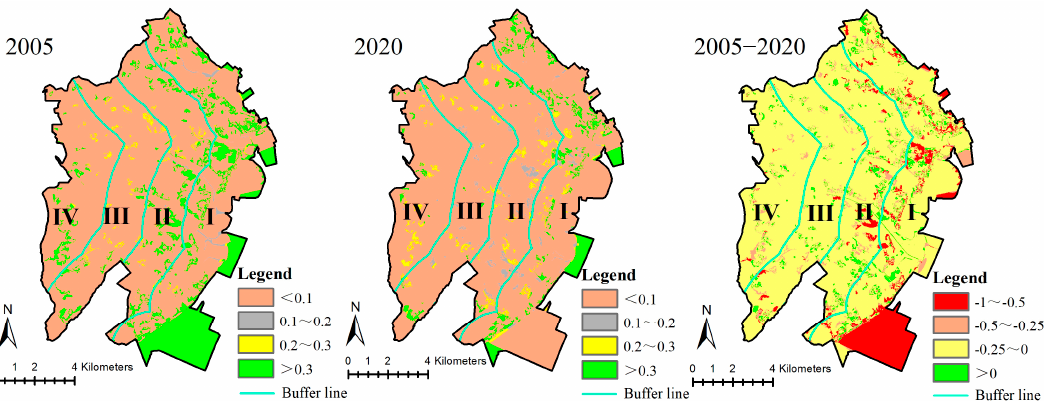
Figure 3. Spatial pattern of habitat quality variation. (Gradient I (0–2 km), gradient II (2–4 km), gradient III (4–6 km) and gradient IV (>6 km) from the coastline to the inland).